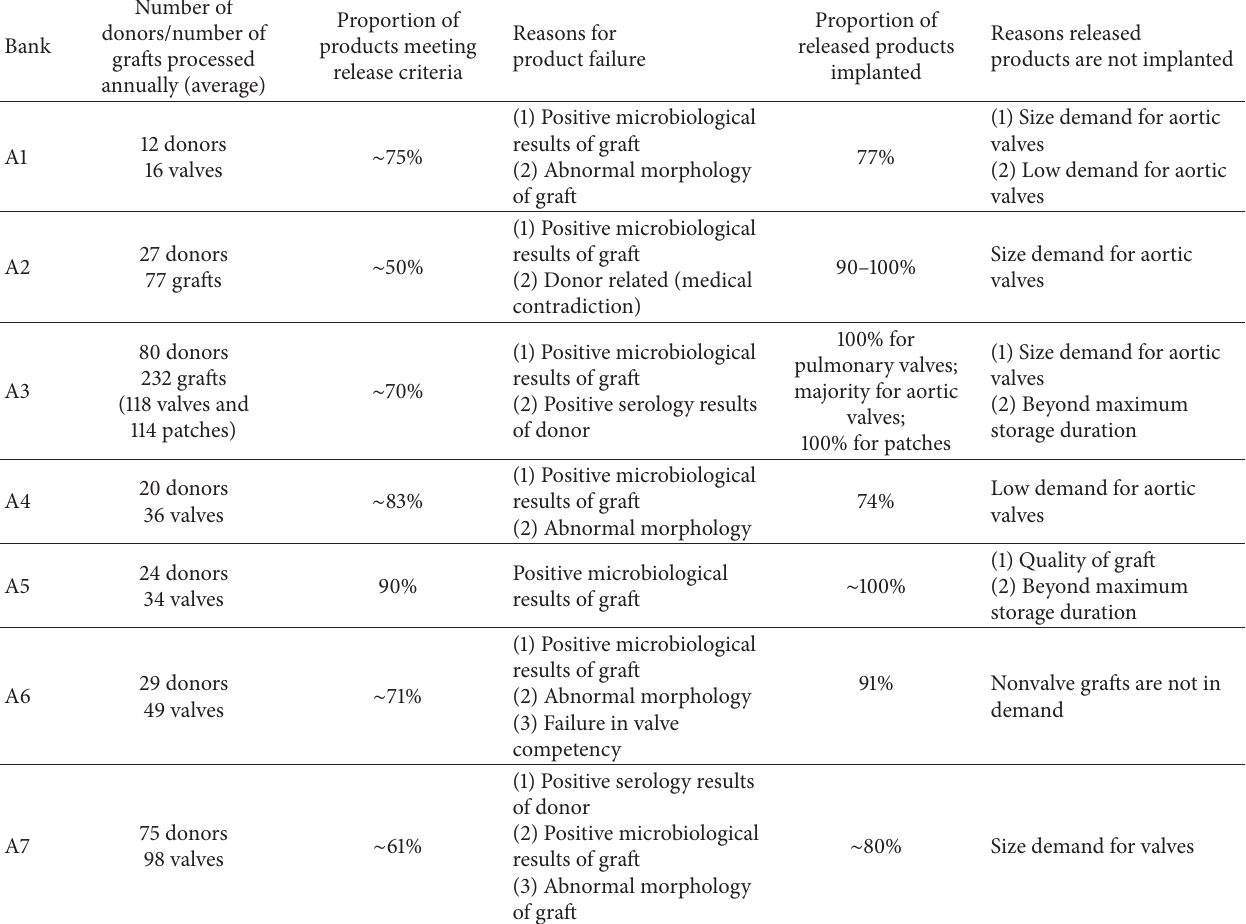
Table 9: Summary table of heart valve outcomes for HVBs in Australasia and South Africa.